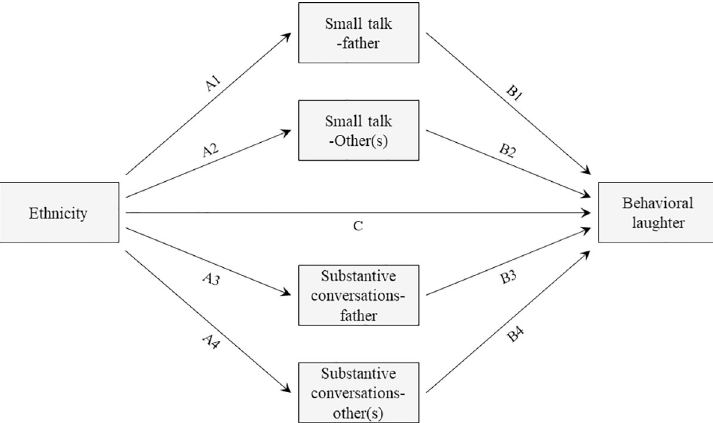
Fig 2. Sociocultural resilience model tested in this study. This model illustrates how four conversation style variables may mediate the association between ethnicity (i.e., being a Latina mother vs. a White-European mother) and behavioral